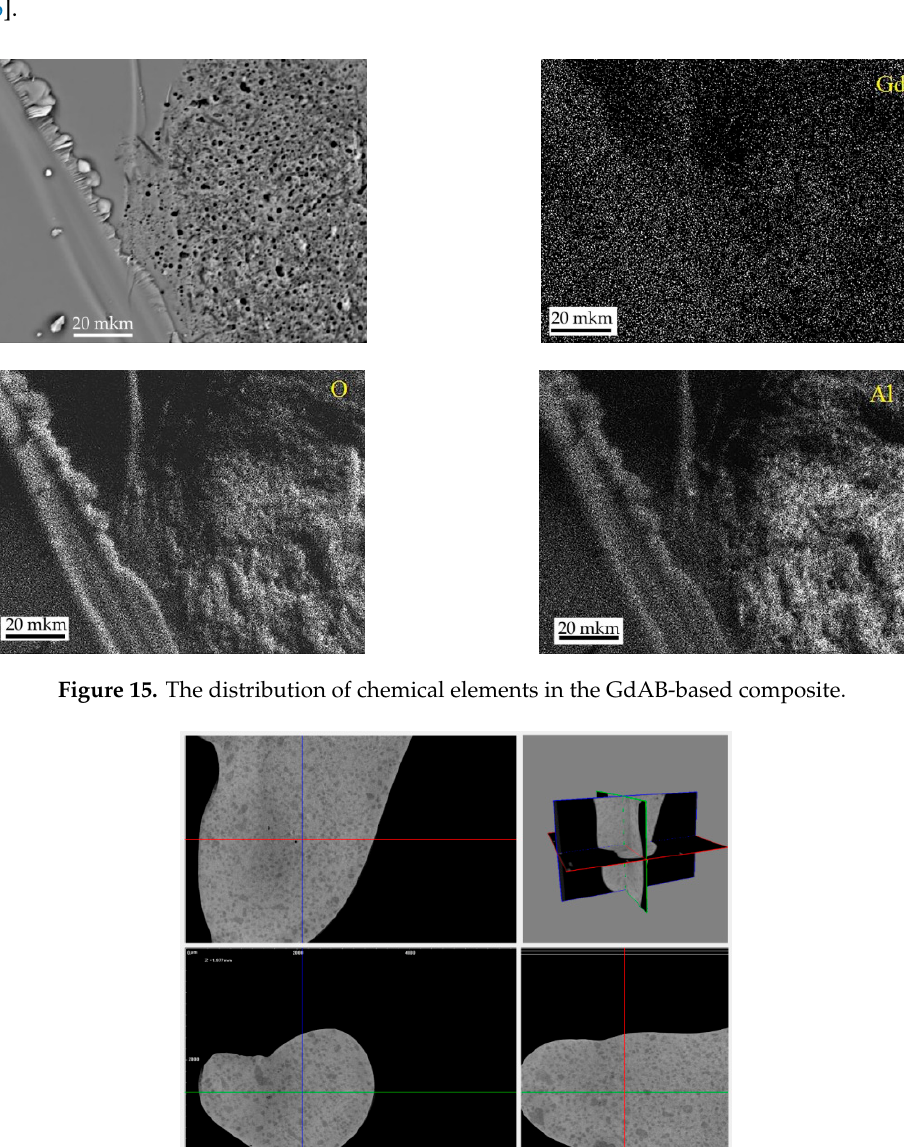
( b ) Figure 14. Backscattering SEM images of ( a ) transparent and ( b ) opaque GdAB-based glass–ceramics [56]. Figure 14b reprinted from the Journal of Crystal Growth, 457, Naprasnikov D.A., Maltsev V.V., Leonyuk N.I., Gorbachenya K.N., Kurilchik S.V., Kisel V.E., Kuleshov N.V. Micro-crystallization and spectroscopic properties of Er, Yb:RAl-borates (R = Y, Gd) obtained in RAl 3 (BO 3 ) 4 –K 2 Mo 3 O 10 –B 2 O 3 – R 2 O 3 and RAl 3 (BO 3 ) 4 –B 2 O 3 systems, 302–306, Copyright (2017), with permission from Elsevier. XRD investigations confirm the presence of the crystalline phase in the as-obtained GdAB-based composites [55,56]. The positions of the detected peaks are in good agreement with the reference data. In the case of the GdAB GC glaze, two crystalline phases were identified: GdAB and Al 5 BO 9 . The distribution of chemical elements in the GdAB-based composite was analyzed. Different concentration profiles for the elements within the selected sample section were identified. The distribution of gadolinium is uniform, while oxygen and aluminum are concentrated in areas where crystalline fractions were detected in the glass matrix (Figure 15). The volumetric X-ray tomography was used to obtain a series of three-axis planar images for the GdAB-based composite (Figure 16). Two phases are clearly detectable in the images: dark, corresponding to microcrystals with a lower X-ray absorption, and light, corresponding to the glass matrix, and characterized by high absorption. Further, several cavities were observed. The volumetric rendering of the GdAB-based composite of a 1 × 1 × 1 mm 3 size clearly demonstrates the spatial distribution of the crystal phase in it. Herewith, the crystalline phase content is up to 32.5%, while the content of cavities corresponds to 0.35% [56].